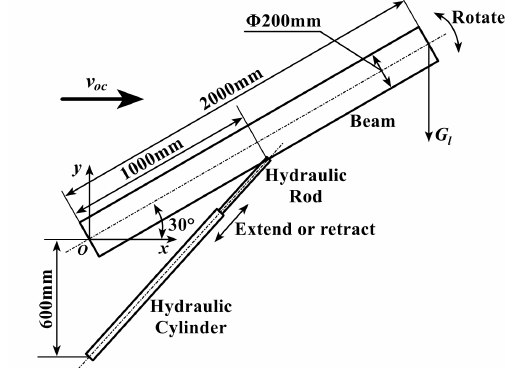
Figure 3. Mechanical